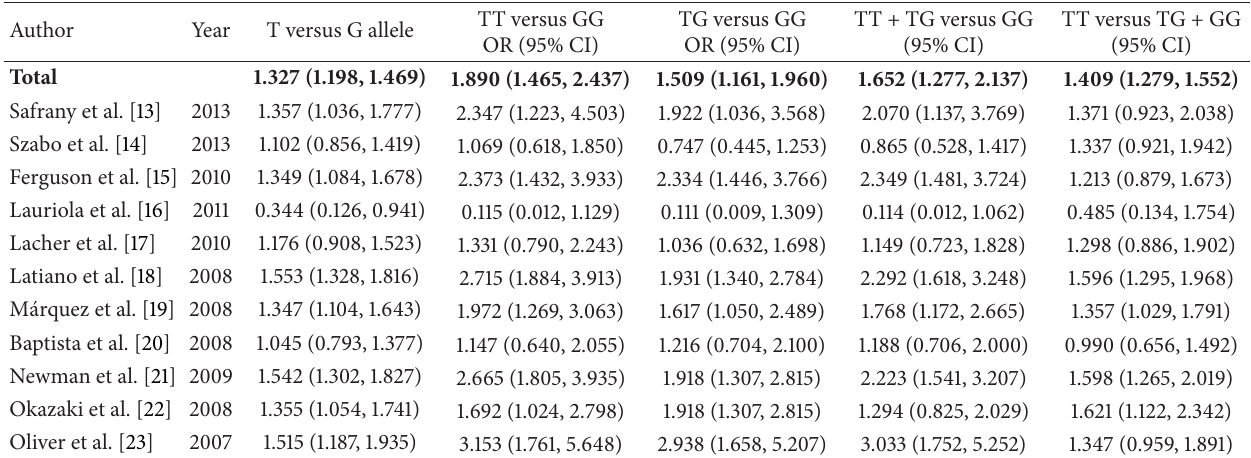
Table 2: Stratified analysis of rs7517847 polymorphism and CD risk in eligible